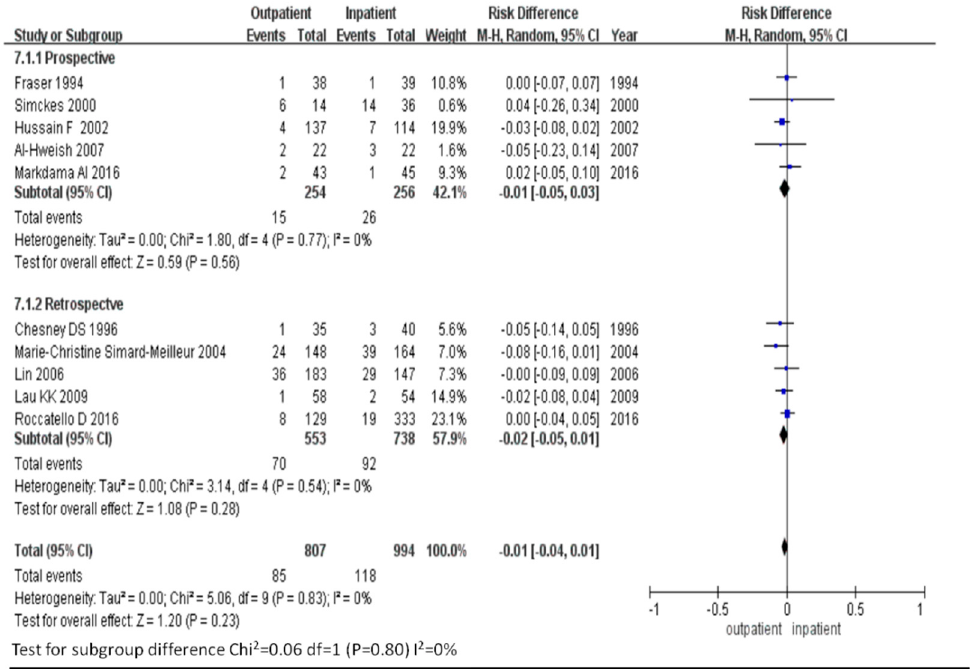
Figure 3. Comparison of bleeding risk in outpatient and inpatient renal biopsies.